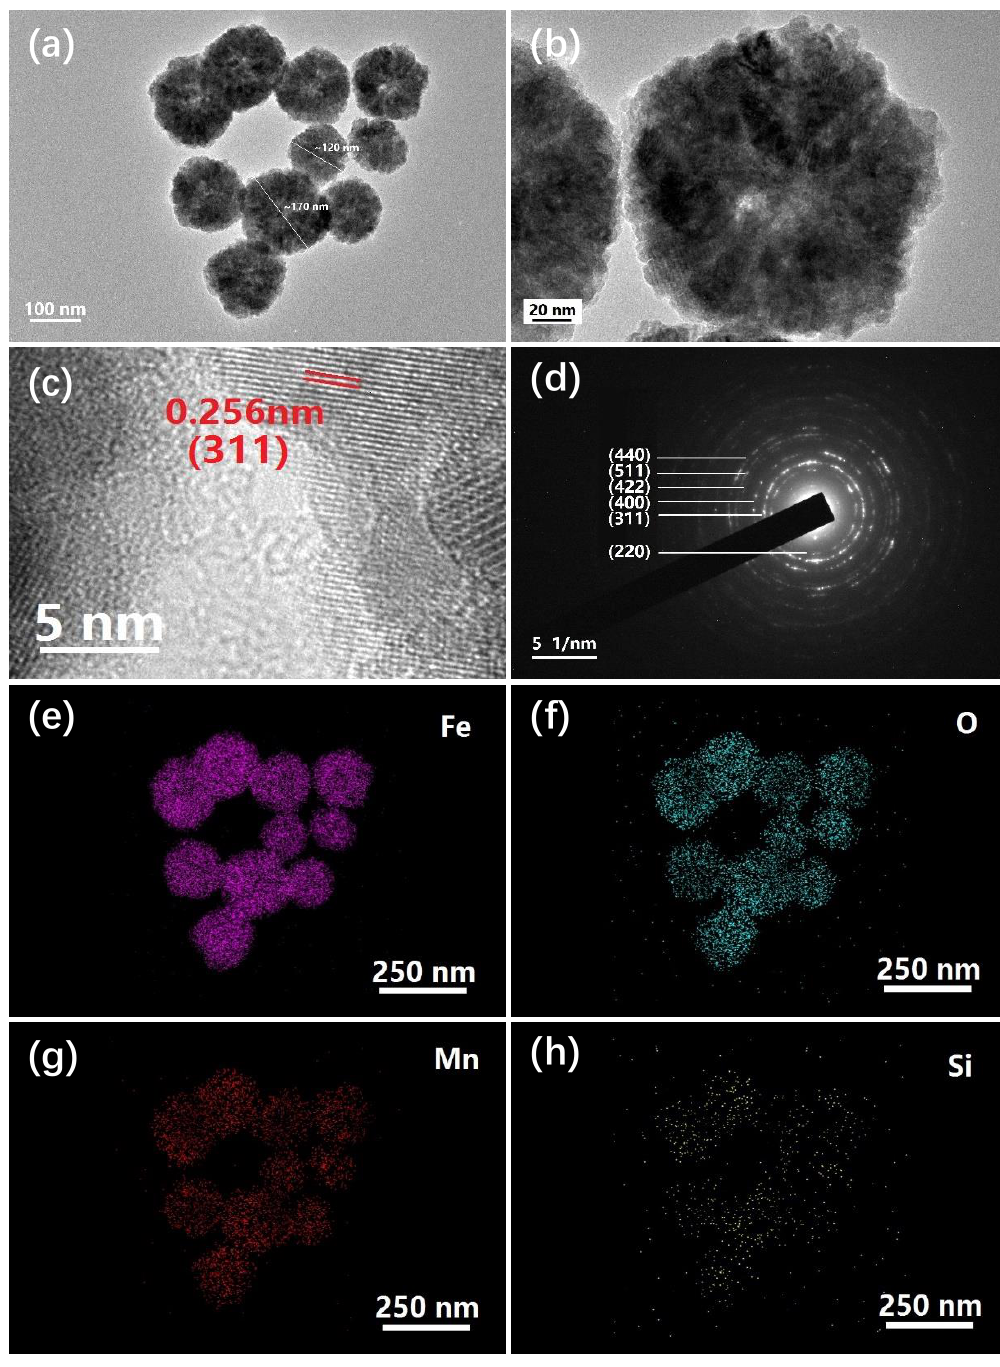
Figure 3. TEM images with different magnifications ( a ) and ( b ), HR-TEM image ( c ), SAED pattern ( d ) and corresponding elemental mapping images of S3 sample ( e )~( h ).